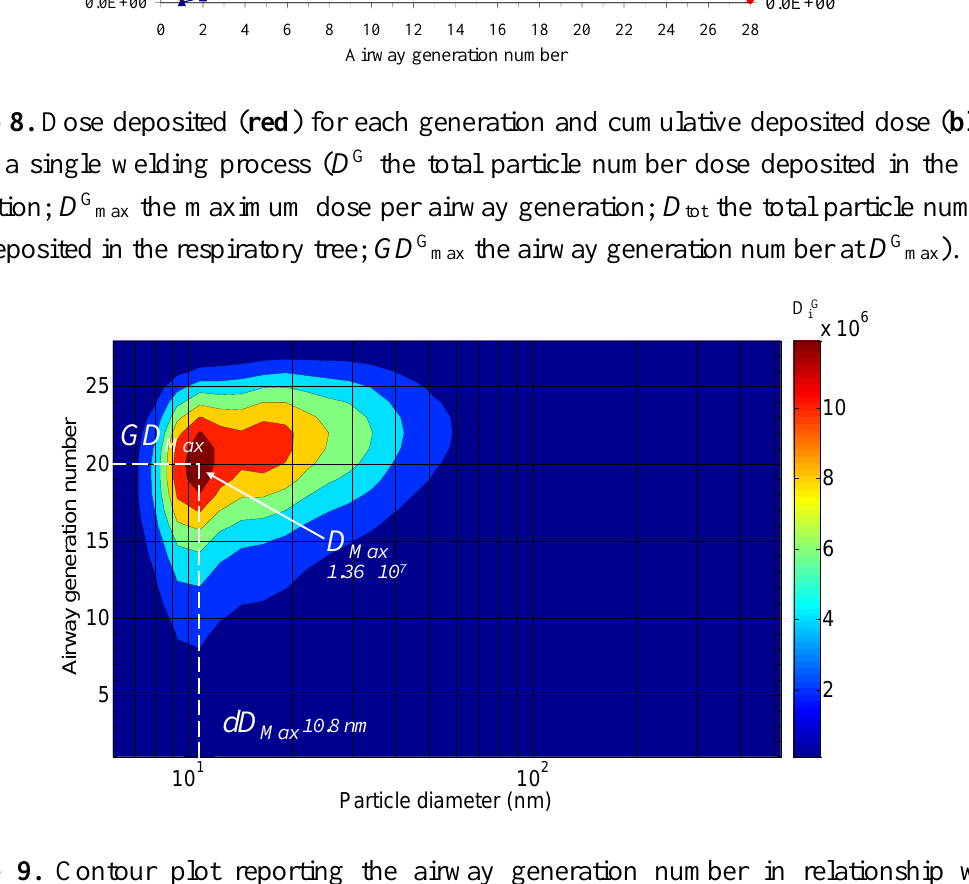
Figure 9. Contour plot reporting the airway generation number in relationship with the particle diameter ( D G i the total particle number dose deposited in the i -generation; GD G max the airway generation number at D G max